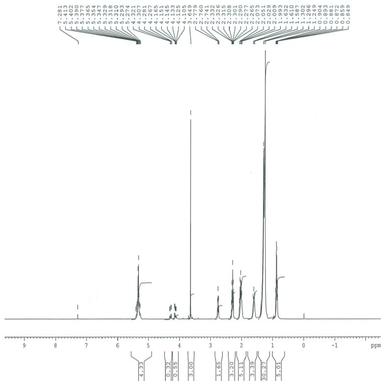
1 H NMR Spectrum of Peelu Crop Biodiesel Showing Various Absorption Peaks Corresponding to Methyl Esters Lab. Sample.